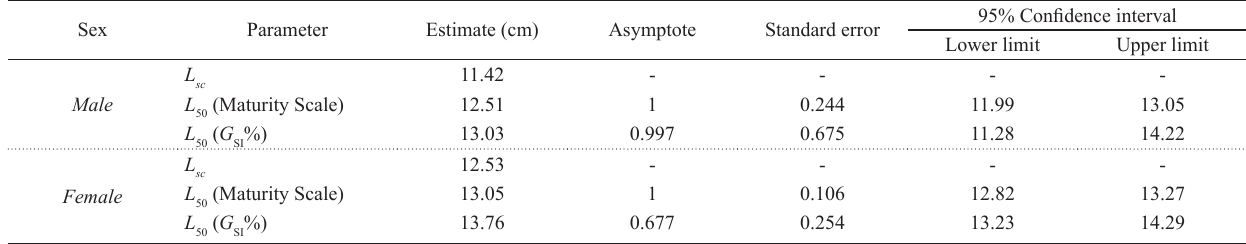
Fig. 4. Frequency of mature individuals as a function of the total length. Female sexual maturity identified by visual inspection of ovarian (A) and G values (B). Male sexual maturity identified by visual inspection of testes (C) and G SI Table 2. Parameters obtained for the estimate of size at first sexual maturity in Auchenipterichthys longimanus using the ) maturity scale and gonadosomatic index ( G SI